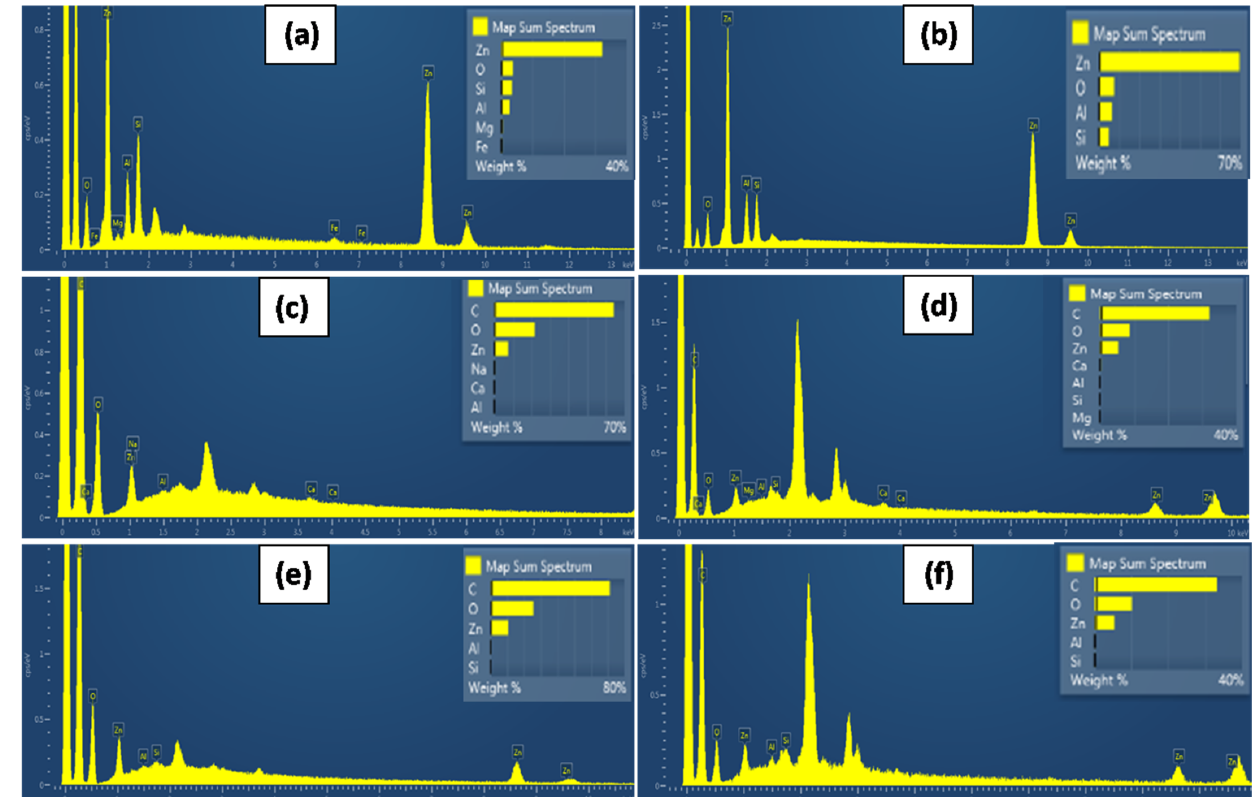
Figure 5. SEM ‐ EDX images and elemental analysis of ( a ) ZnO@Mt and ( b ) ZnO@HNT nanohybrid Figure 5. SEM-EDX images and elemental analysis of ( a ) ZnO@Mt and ( b ) ZnO@HNT nanohybrid powders, of CS/PVOH/ZnO@Mt ( c ) surface and ( d ) cross ‐ section, and of CS/PVOH/ZnO@HNT ( e ) powders, of CS/PVOH/ZnO@Mt ( c ) surface and ( d ) cross-section, and of CS/PVOH/ZnO@HNT surface and ( f ) cross ‐ section. ( e ) surface and ( f )